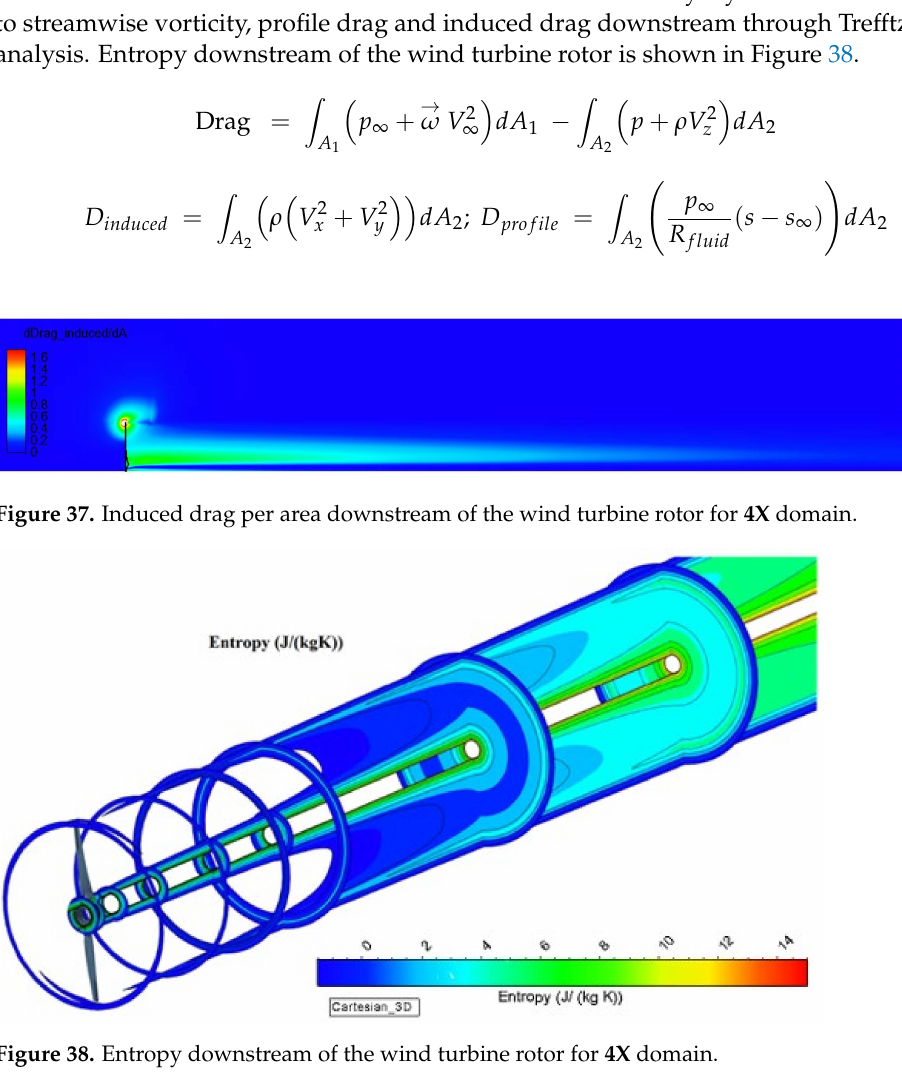
Figure 38. Entropy downstream of the wind turbine rotor for 4X